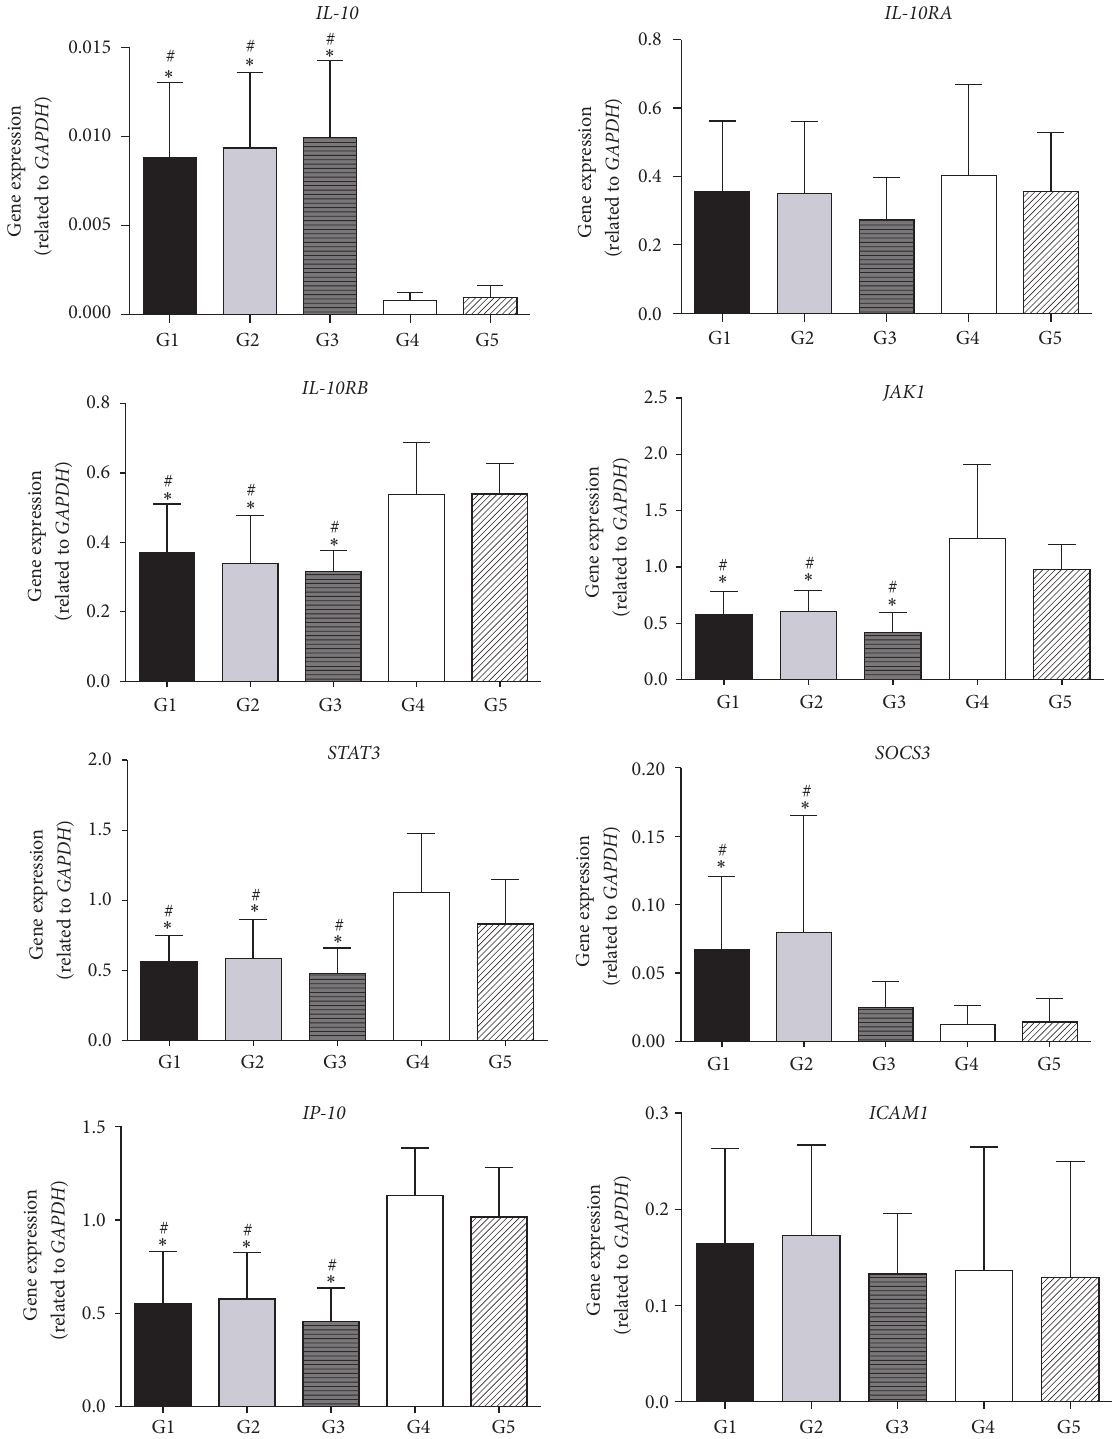
Figure 1: Signaling pathway of IL10 gene in groups G1, G2, G3, G4, and G5. All values were normalized to GAPDH . Data represent the mean ± SD. # 𝑃 ≤ 0.05 compared to G4 group; ∗ 𝑃 ≤ 0.05 compared to group G5. Comparisons between all groups were performed by the Kruskal–Wallis test, and Dunn test was used to correct for multiple